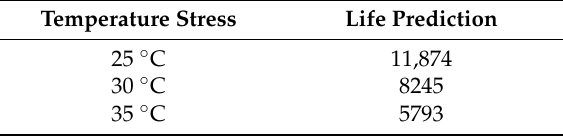
Table 6. Prediction of relay life at ambient